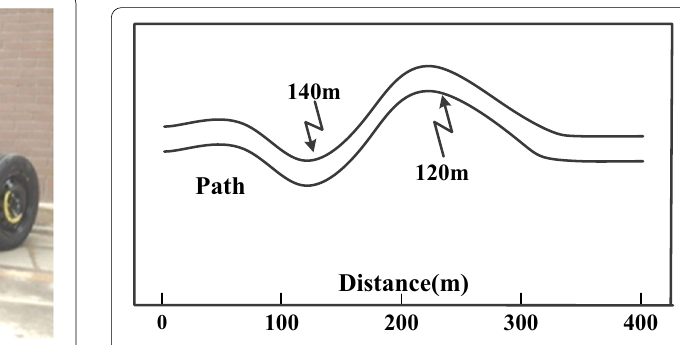
Figure 6 Prototype automated electric vehicle Figure 7 Desired trajectory in experimental test